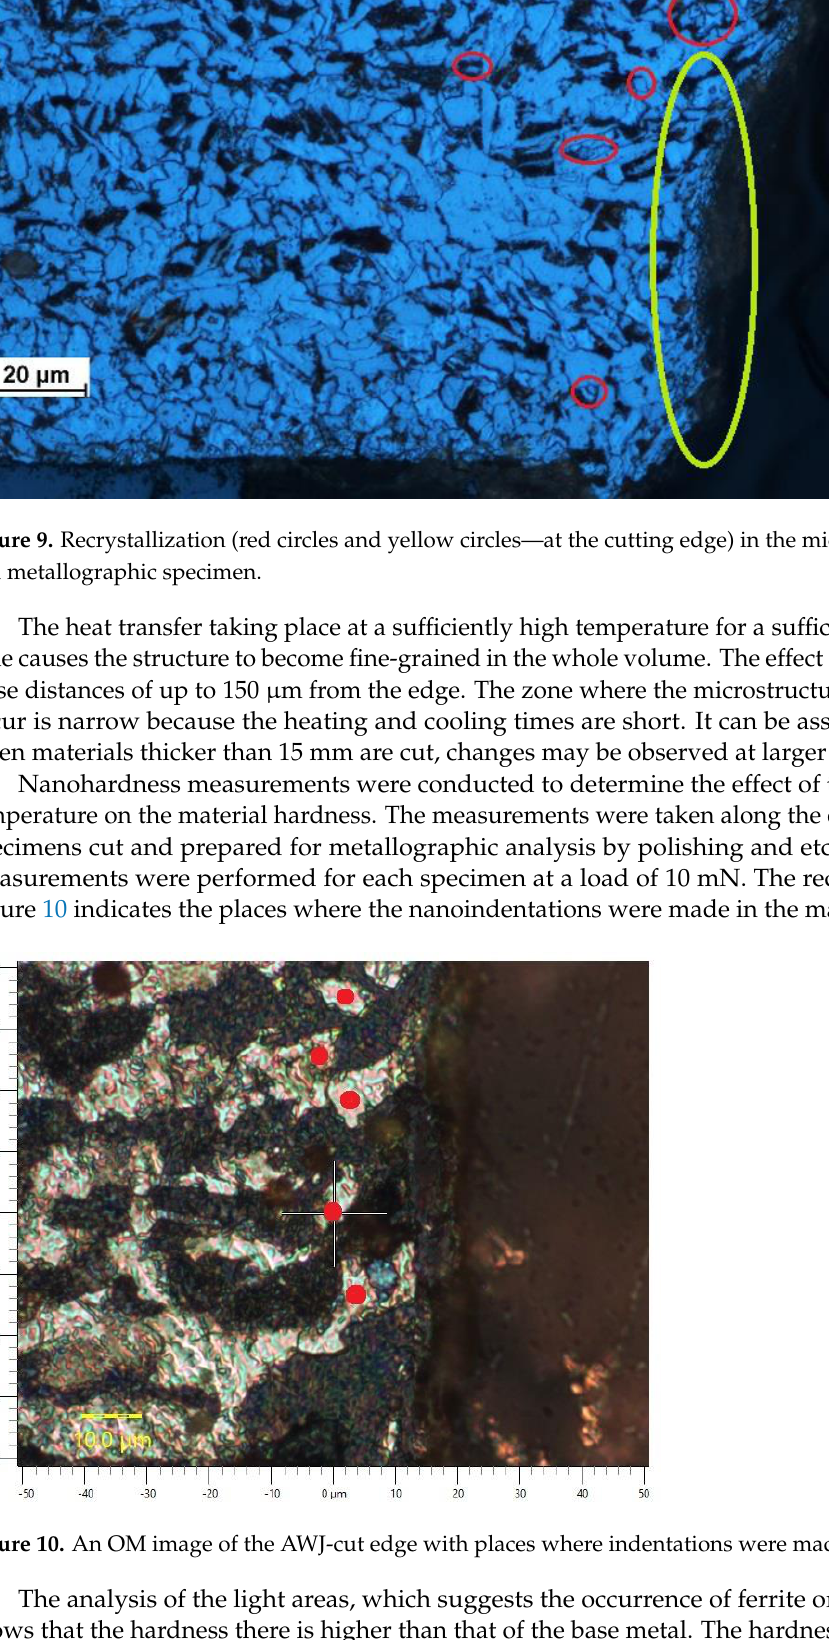
Figure 8. Recrystallization (red circles) and polygonization (red rectangles) in the microstructure of a metallographic specimen.